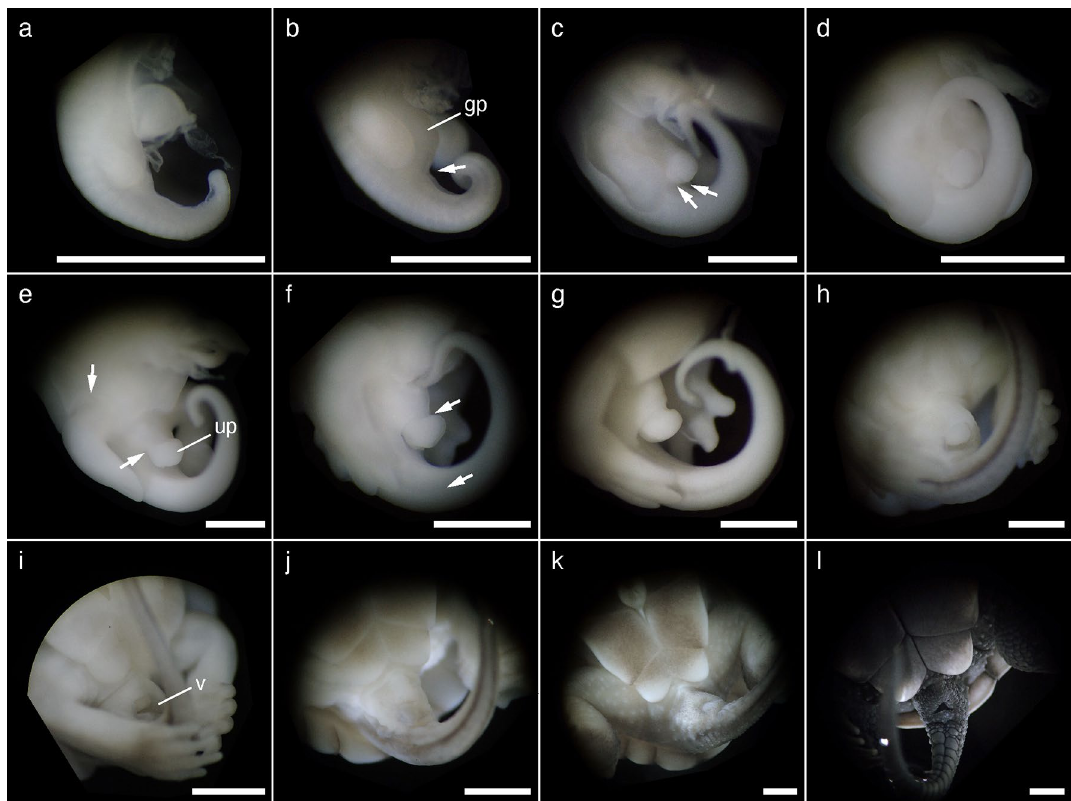
Figure 5. Formation of cloaca and its surrounding structures at stages 13–24 of Mauremys reevesii . ( a ) Stage 13. Genital protuberance is still absent. ( b ) Stage 14. The arrow indicates a slight crease. ( c ) Stage 15. The left arrow indicates a crease between genital protuberance and tail, and the right arrow indicates a crease distinguishing urogenital papilla. ( d ) Stage 16. ( e ) Stage 17. The upper arrow indicates the posterior border of the plastron. The lower arrow indicates a crease. ( f ) Stage 18. The upper arrow indicates a fold surrounding the urogenital papilla. The lower arrow indicates a line of pigmentation. ( g ) Stage 19. ( h ) Stage 20. ( i ) Stage 21. ( j ) Stage 22. ( k ) Stage 23. ( l ) Stage 24. gp, genital protuberance; up, urogenital papilla; v, vent. The scale bar is 2.5